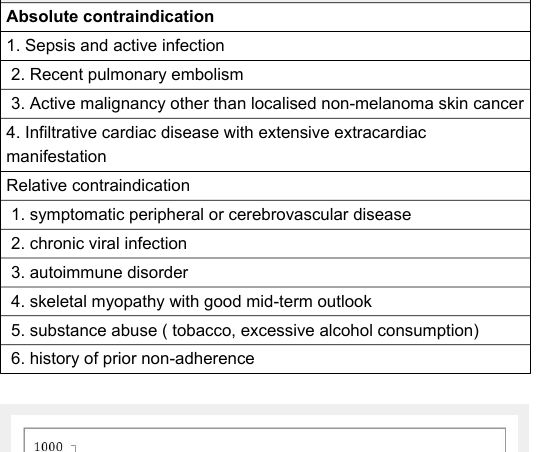
Table 3: Contraindication to heart transplantation.